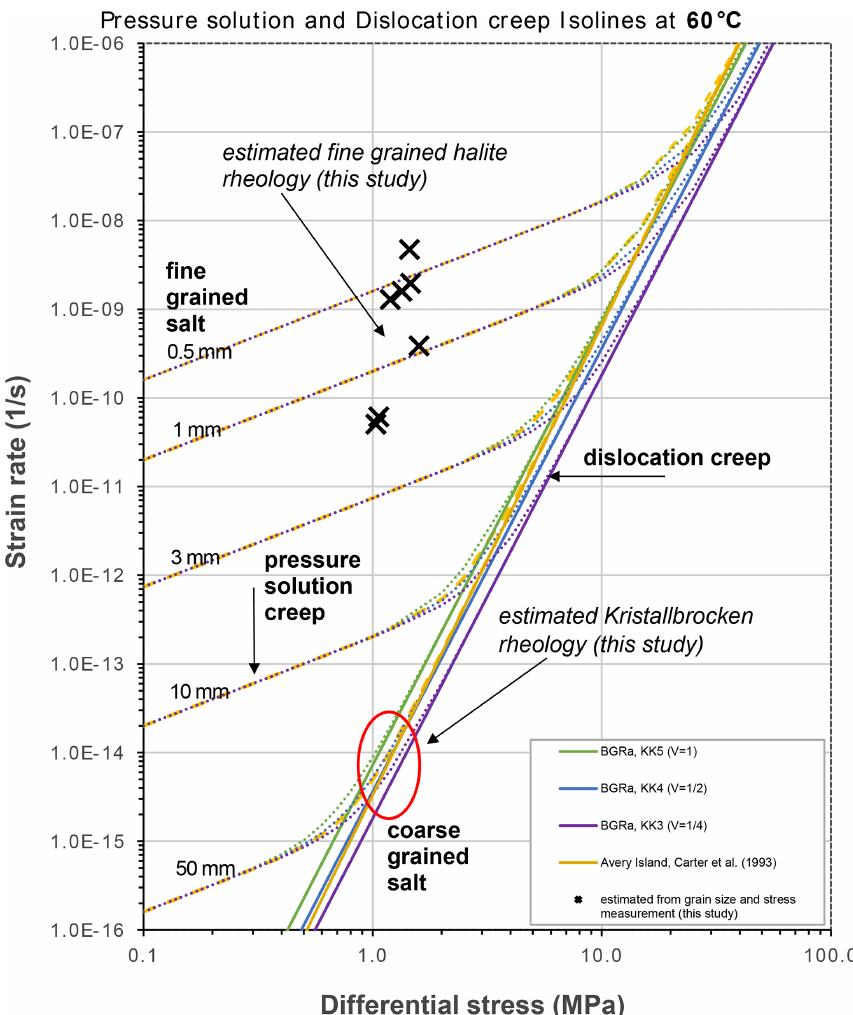
Figure 10. Comparison of differential stresses measured in Kristallbrocken and matrix halite for samples where both were available ( σ = 107 · (D − 0 . 87 ), D = subgrain size; Carter et al., 1993; Schléder and Urai, 2005) with 95% confidence intervals based on all measured subgrains per sample. Measurements indicate comparable differential stresses for both halite types, but slightly lower values for differential stress in Kristallbrocken of this study. Differential stresses from Teutschenthal were measured based on micrographs presented in Küster et al. (2008) for matrix halite and Küster (2011) for Kristallbrocken and show comparable, slightly lower differential